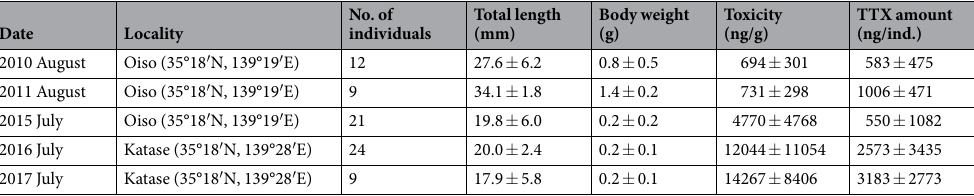
Table 1. Toxicity (concentration) and amount of TTX in wild pufferfish Takifugu niphobles juveniles. Data are represented mean ± standard